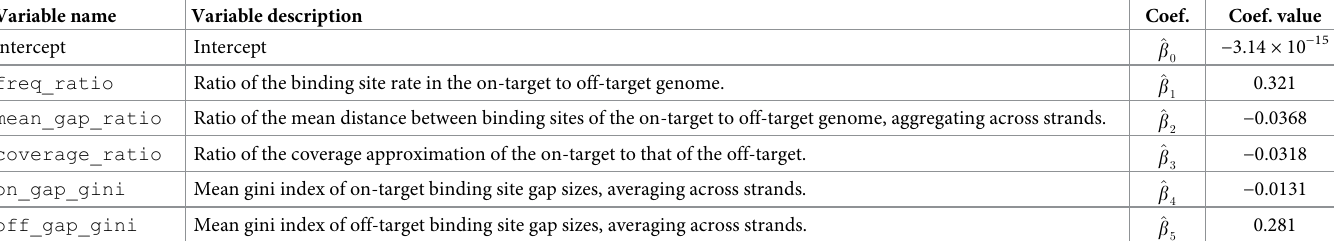
Table 2. Ridge regression variable descriptions and coefficient values for primer set